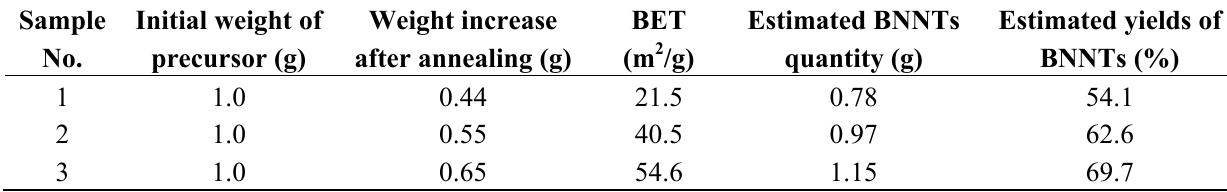
Table 2. Estimation of BNNTs production